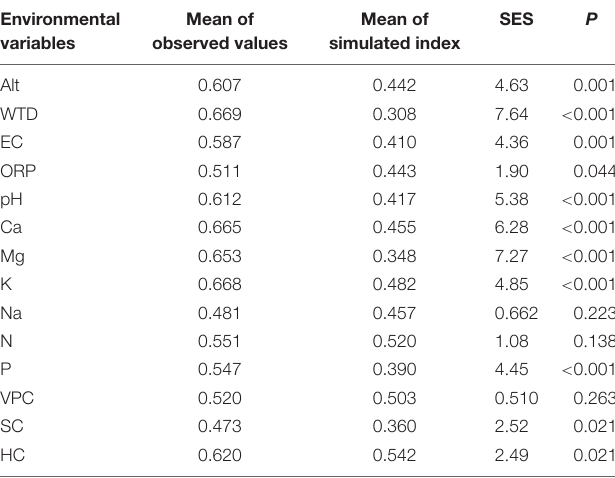
TABLE 6 | Niche overlap analysis for all the environmental